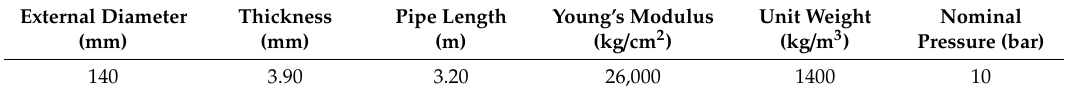
Table 1. Main features of PVC-A (PVC-Alloy) tested